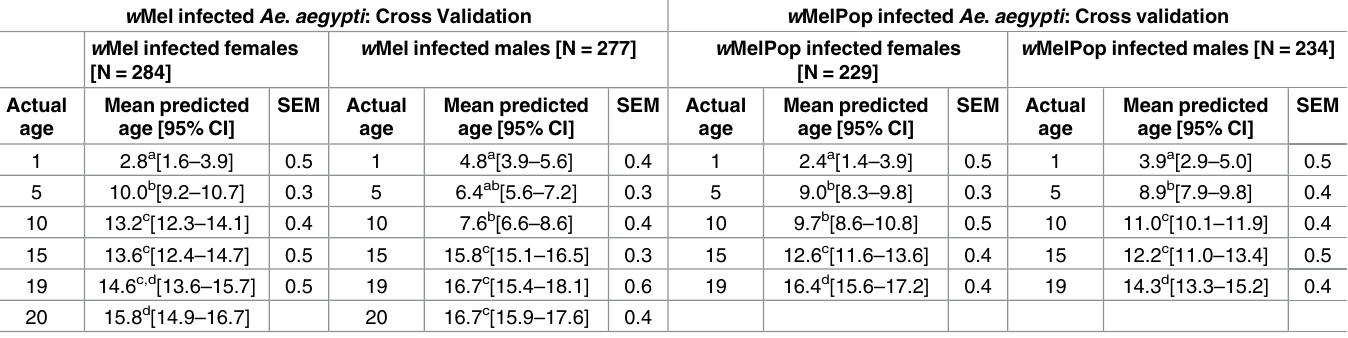
Means followed by the same letter are not significantly different at P < 0.05 when using Tukey post hoc test Actual and mean predicted ages shown are in days 1 The accuracy of samples used to develop calibration